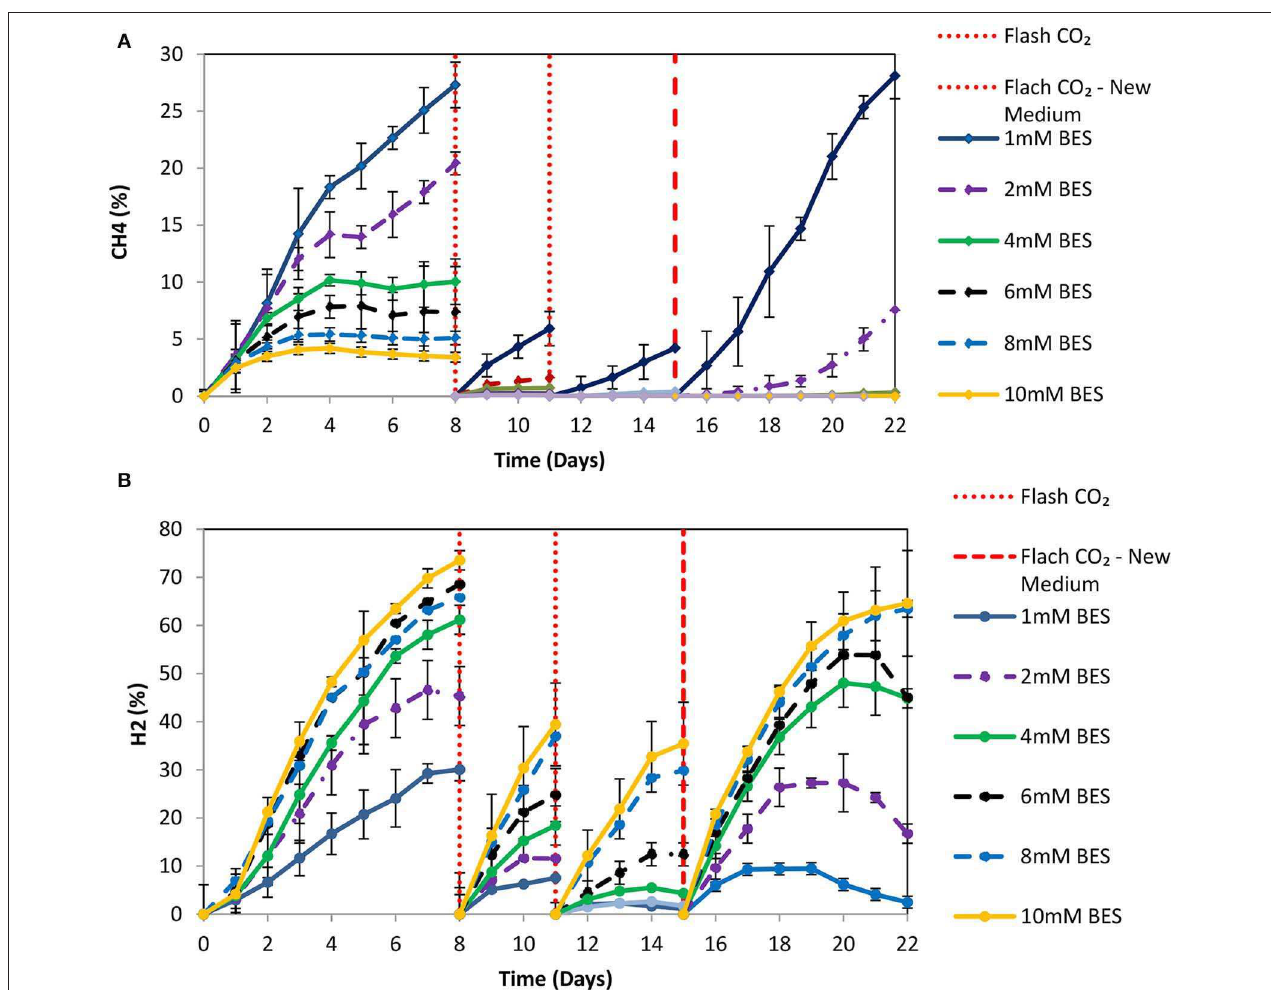
FIGURE 8 | (A) CH 4 production over time for anaerobic granular sludge exposed to 1–10mM BES, 100 g/L ZVI and operation at pH 6–6.5. On day 15, 90% of the media was replaced with a new media. (B) H 2 production over time for anaerobic granular sludge exposed to 1–10mM BES, 100 g/L ZVI and operation at pH 6–6.5. On day 15, 90% of the media was replaced with a new